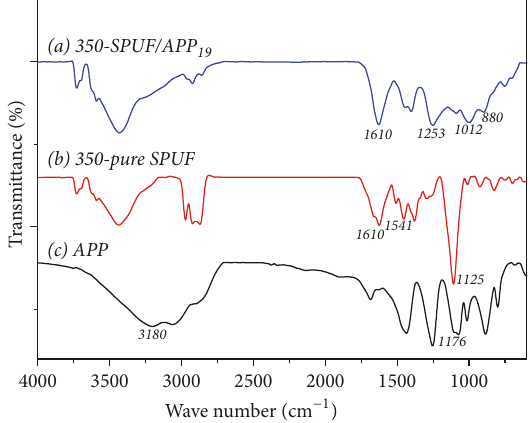
Figure 3: FTIR of pure SPUF, SPUF/APP 19 , and